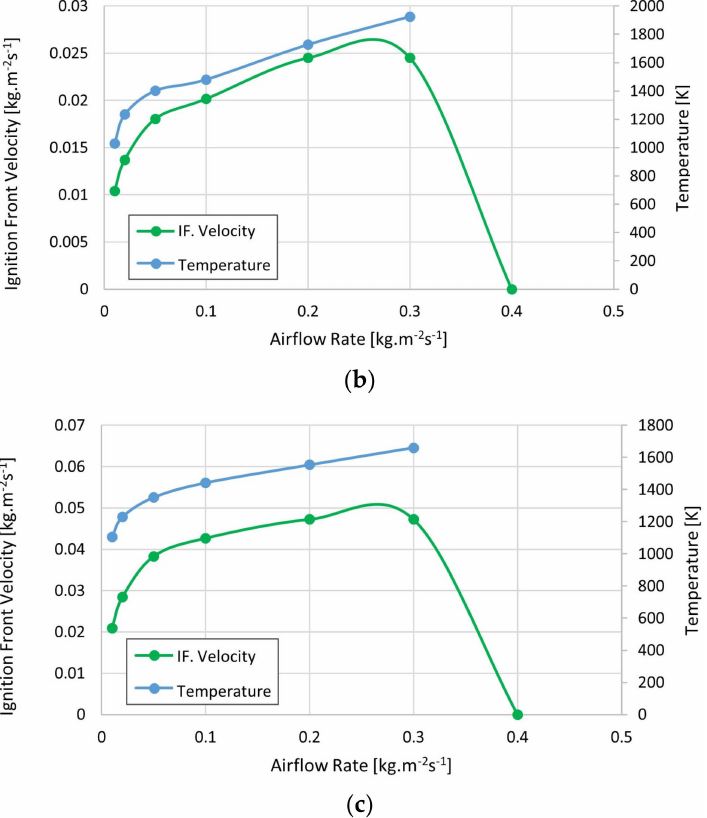
Figure 5. Ignition front velocity and maximum temperature at different airflow rates for Lippia origanoides bagasse samples: ( a ) stems (S); ( b ) leaves (L) and ( c ) mixture of stems and leaves